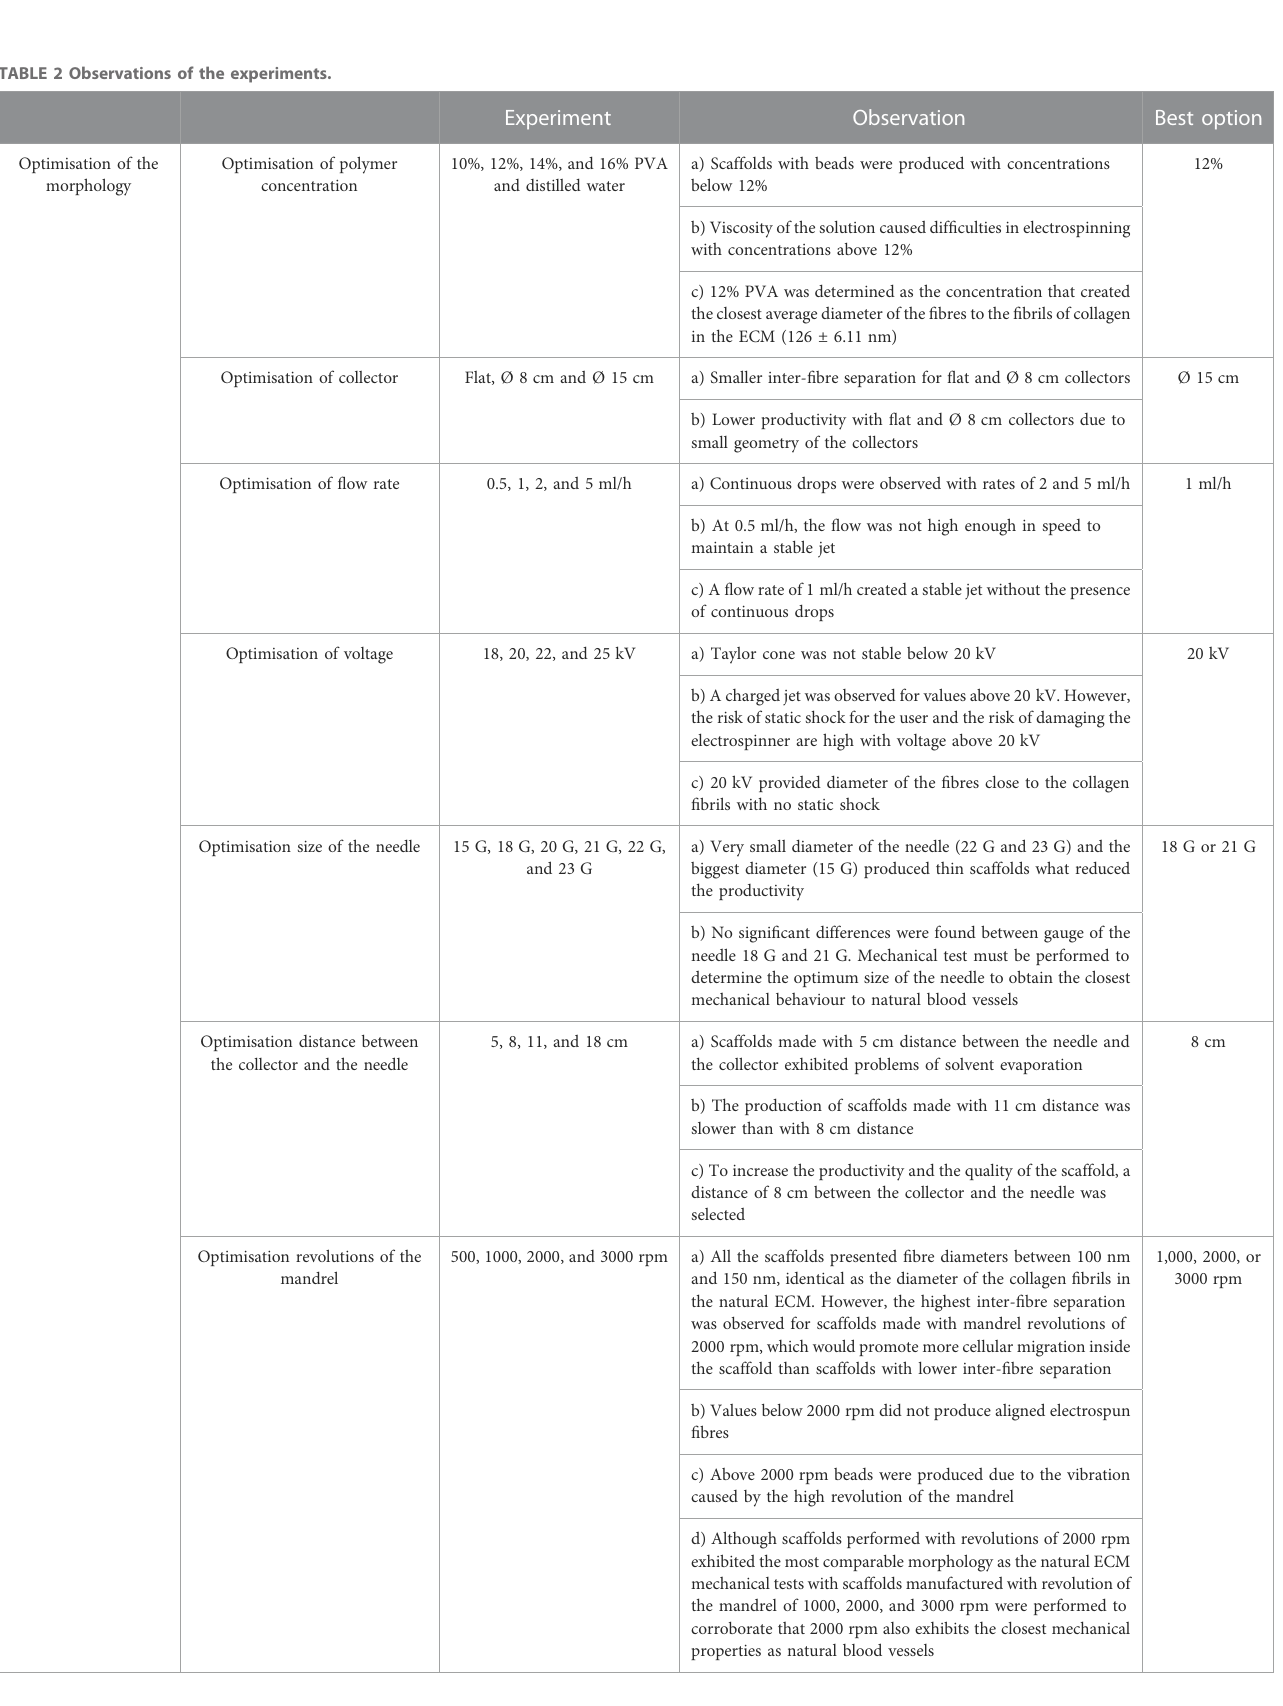
the prediction of the inter- fi bre separation. The MSE remained stable for both the diameter of the fi bres and the inter- fi bre separation.